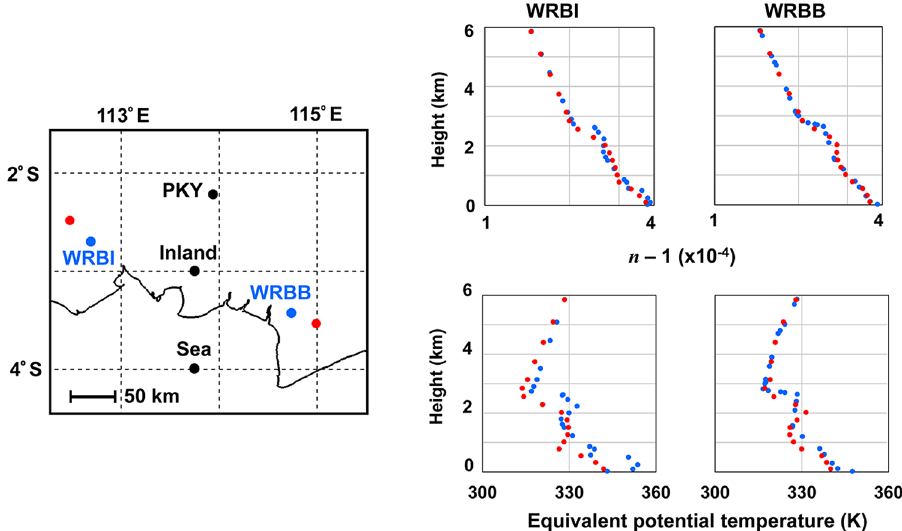
Figure 4. (Left) Blue dot: locations of BMKG stations, WRBI and WRBB. Red dot: MERRA-2/NASA database locations. Two black dots, “inland” and “sea”, are for inland and on-sea locations. PKY stnads for the Tjilik Riwut BMKG station in Palangka Raya, (Right) vertical profiles of the refractive index, n , and equivalent potential temperature. Blue dot: radiosonde data. Red circle: derived from MERRA-2/NASA database. At 00Z on 13 September 2018. The scale for refractive index is logarithmic. (Visual Studio 2017, EXCEL 2019, Power Point